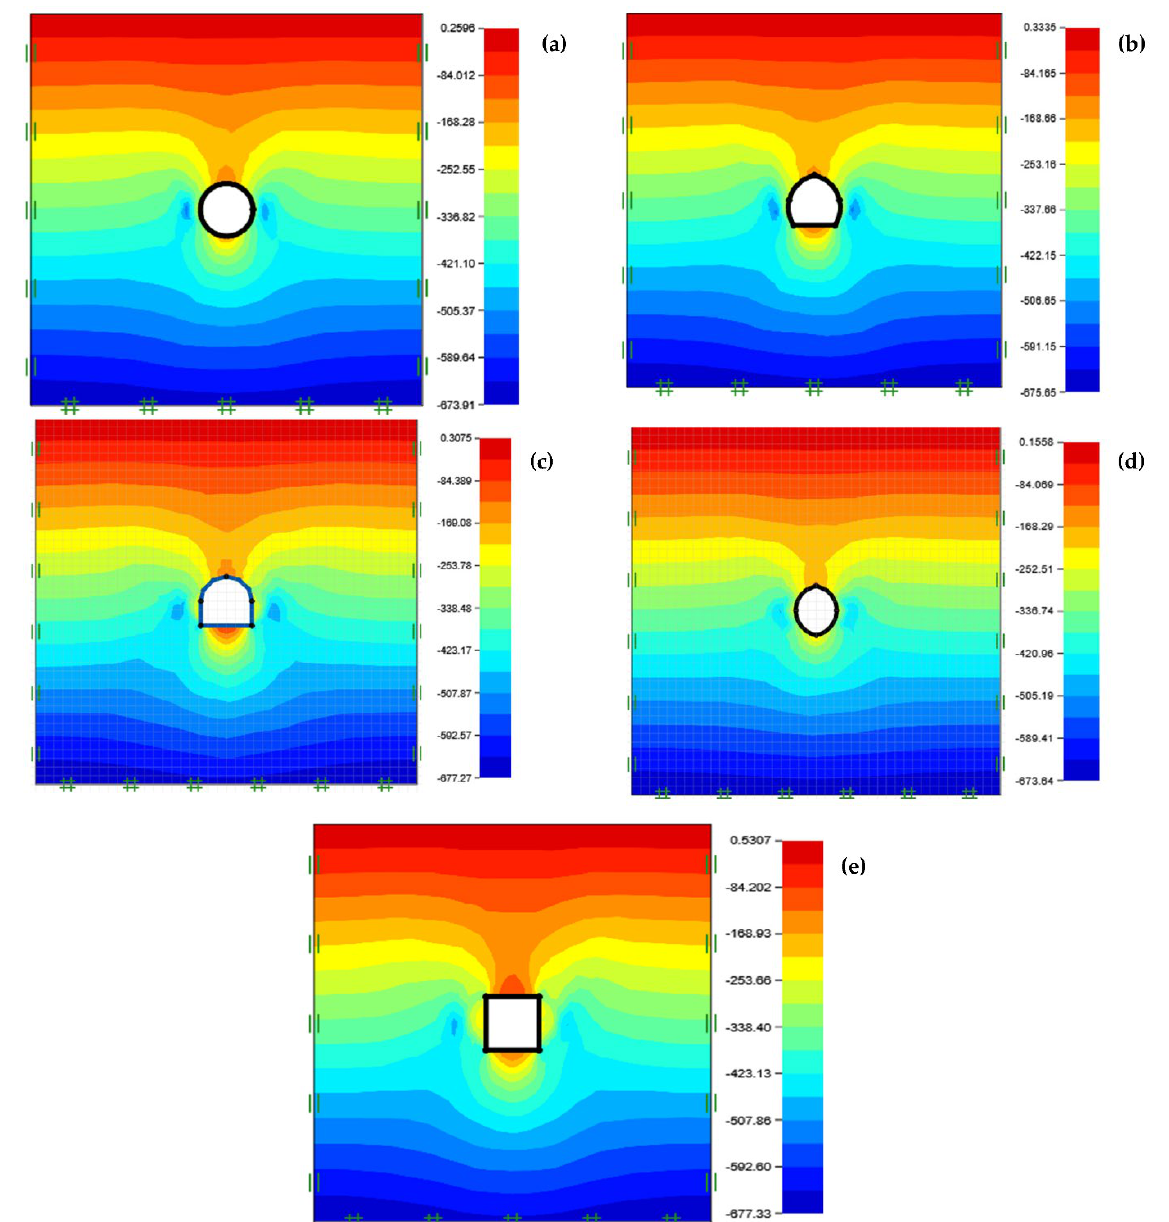
Figure 14. Principal stresses ( σ xx ) in soil having ( a ) circular-, ( b ) arch-, ( c ) horseshoe-, ( d ) elliptical-, and ( e ) square-shaped openings.